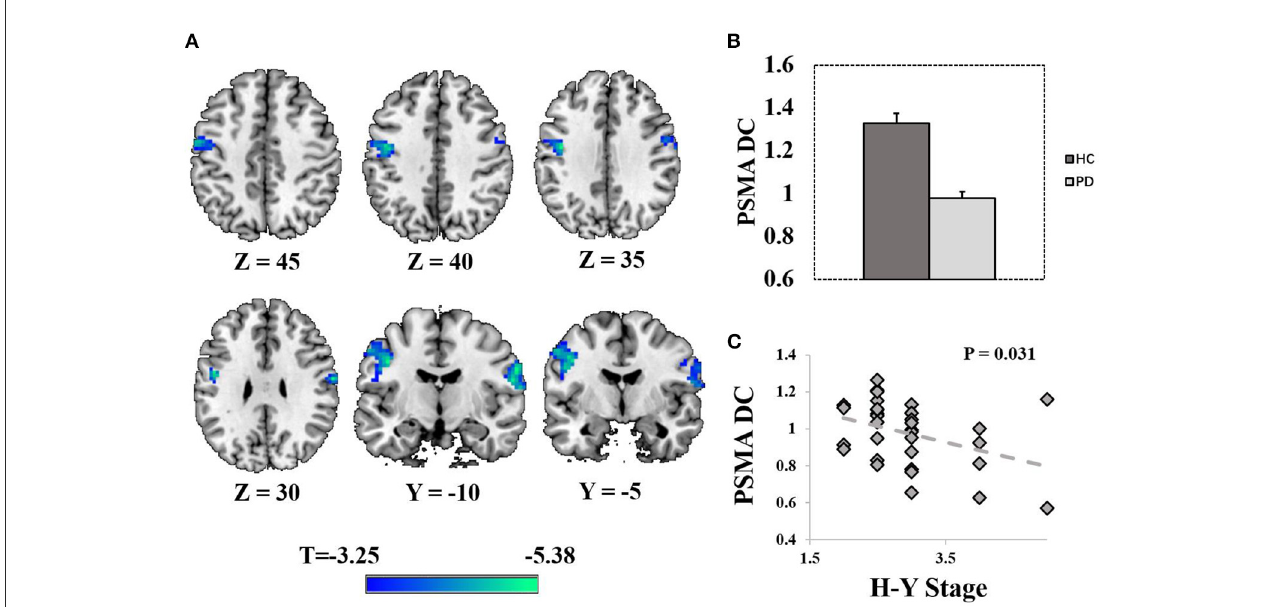
FIGURE1 Display of significantly reduced degree centrality in the PSMA. (A) Shows the spatial distribution of the PSMA cluster (P unccorrected < 0.001). (B) Shows the bar plots of normalized DC from the bilateral PSMA cluster. (C) Shows the correlation between normalized DC and the H-Y stage in PD patients. Error bars represent standard